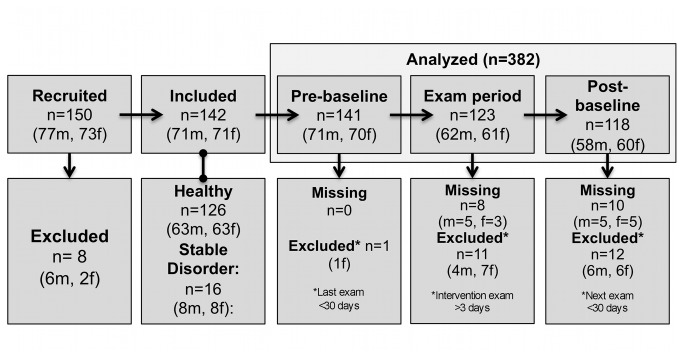
Participant flow-chart.